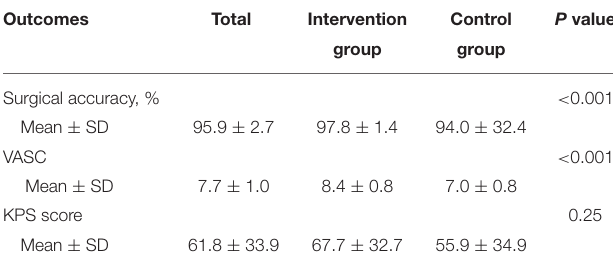
TABLE 4 | Outcomes at 6-month follow-up for patients.